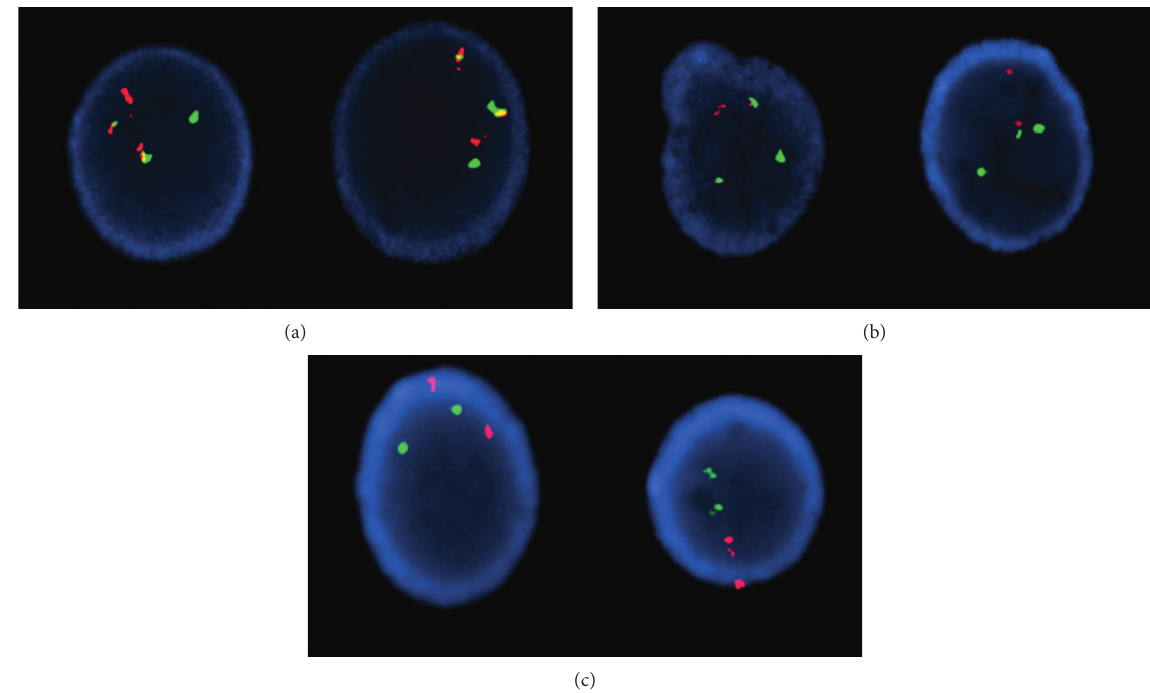
Figure 3: Fluorescence in situ hybridization (FISH) studies on interphase cells showing (a) CBFB and MYH11 rearrangement, dual fusion probe (Cytocell); (b) BCR/ABL1 translocation, dual fusion probe (Cytocell); and (c) normal FISH signal pattern for RUNX1T1/RUNX1 rearrangement, dual fusion probe (Abbott